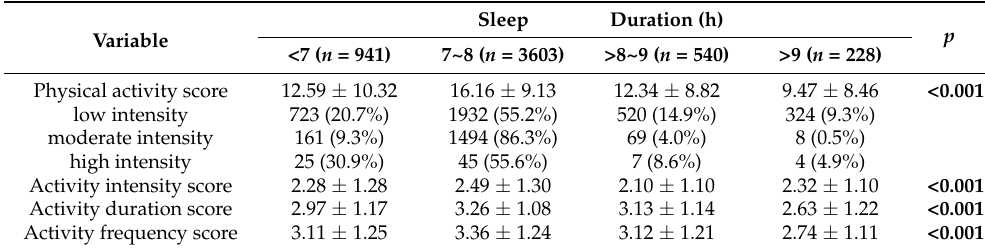
Table 3. Physical activity across categories of average sleep